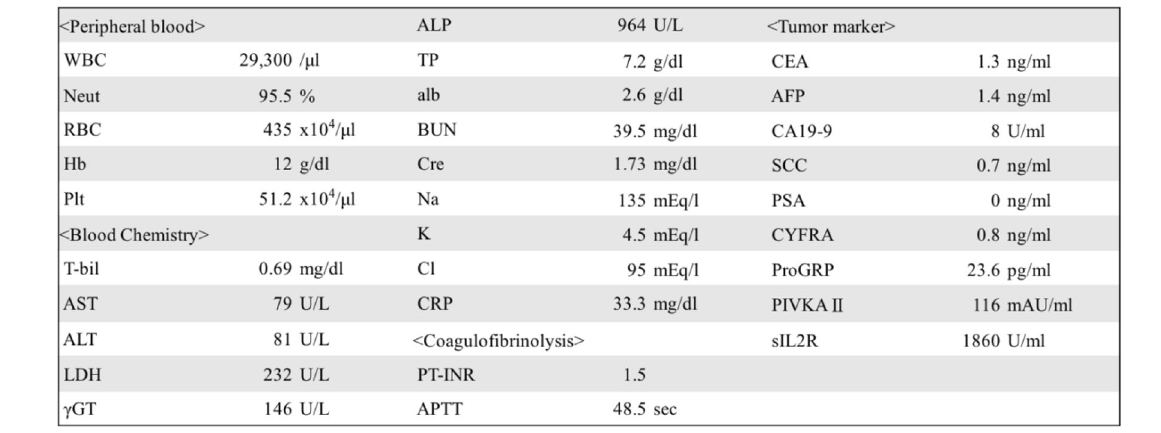
Table 1 Laboratory test results on admission. Increase in inflammation reaction and renal dysfunction was recognized